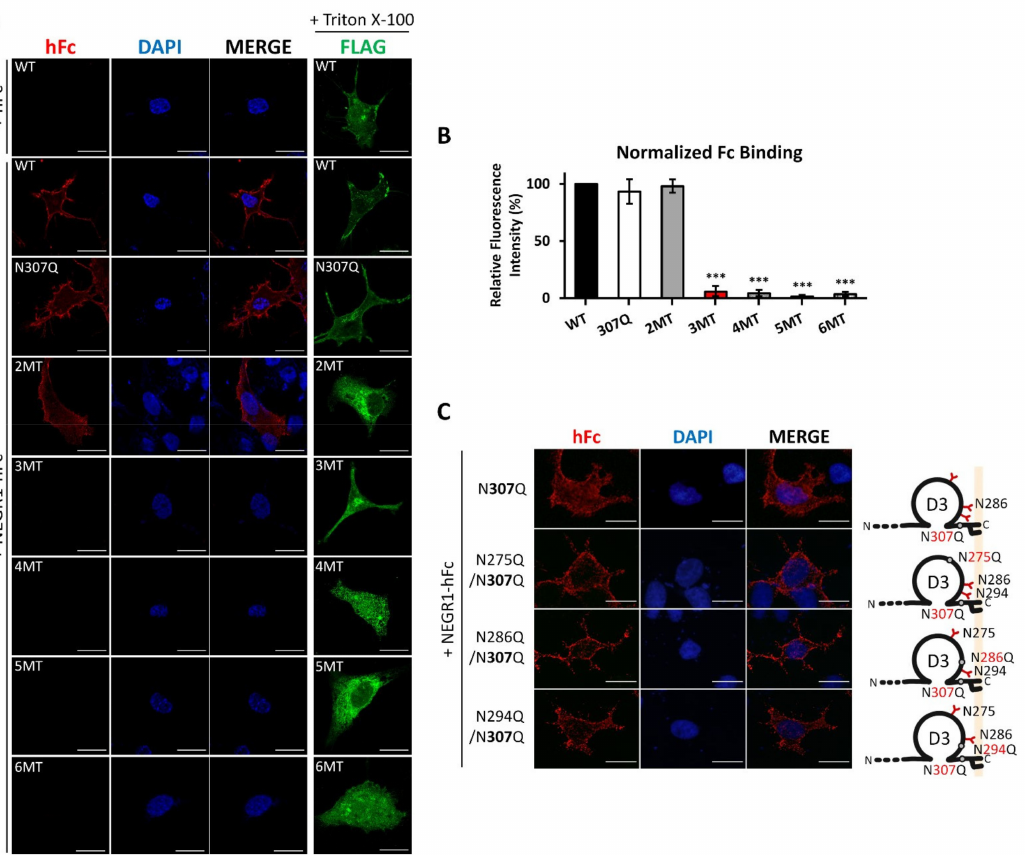
Figure 6. Homophilic binding activities of NEGR1 mutants. ( A ) In situ homophilic interaction using soluble NEGR1 protein. After SKOV3 cells were transfected with NEGR1 WT and mutants for 24 h, cells were incubated in a serum-free medium containing purified hFc or NEGR1-hFc (30 µ g/mL) for 1 h at 4 ◦ C. After fixation, bound NEGR1-hFc was visualized by incubation with Alexa Fluor 595 anti-hFc antibody (1:50) for 1 h. To verify the protein expression, cells were separately immunostained with anti-FLAG antibody under cell permeabilization conditions. Images were obtained using the Zeiss LSM 880 confocal microscope. ( B ) Homophilic interaction was determined by calculating the relative fluorescence intensities of cells stained with anti-hFc antibody after normalization to those with anti-FLAG antibody. Data are means ± standard deviation *** p < 0.001 ( C ) Double mutants commonly containing N307Q were generated, and an in-situ binding assay was performed using